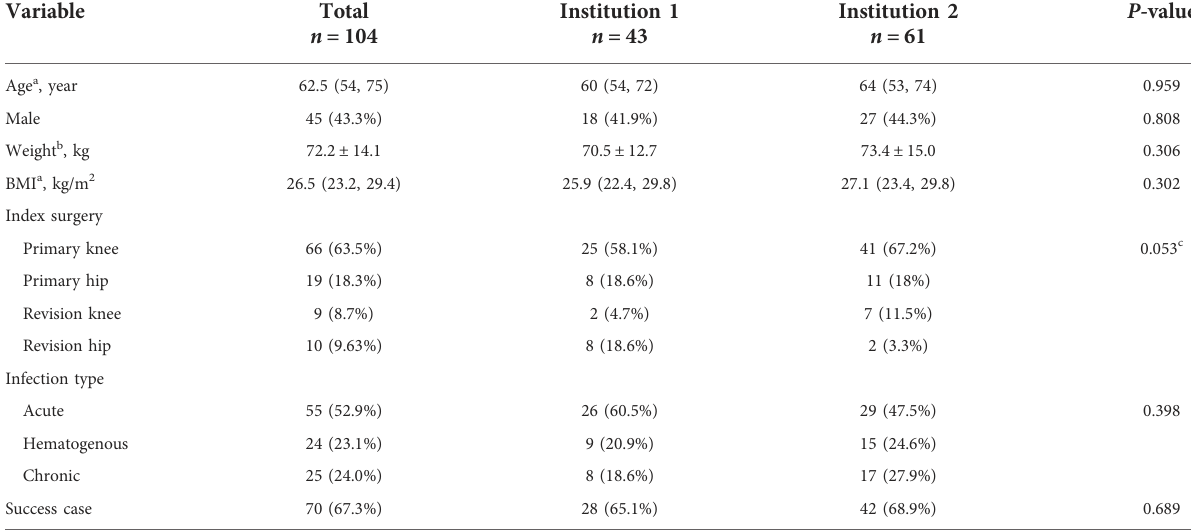
TABLE 1 Demographic data between the two